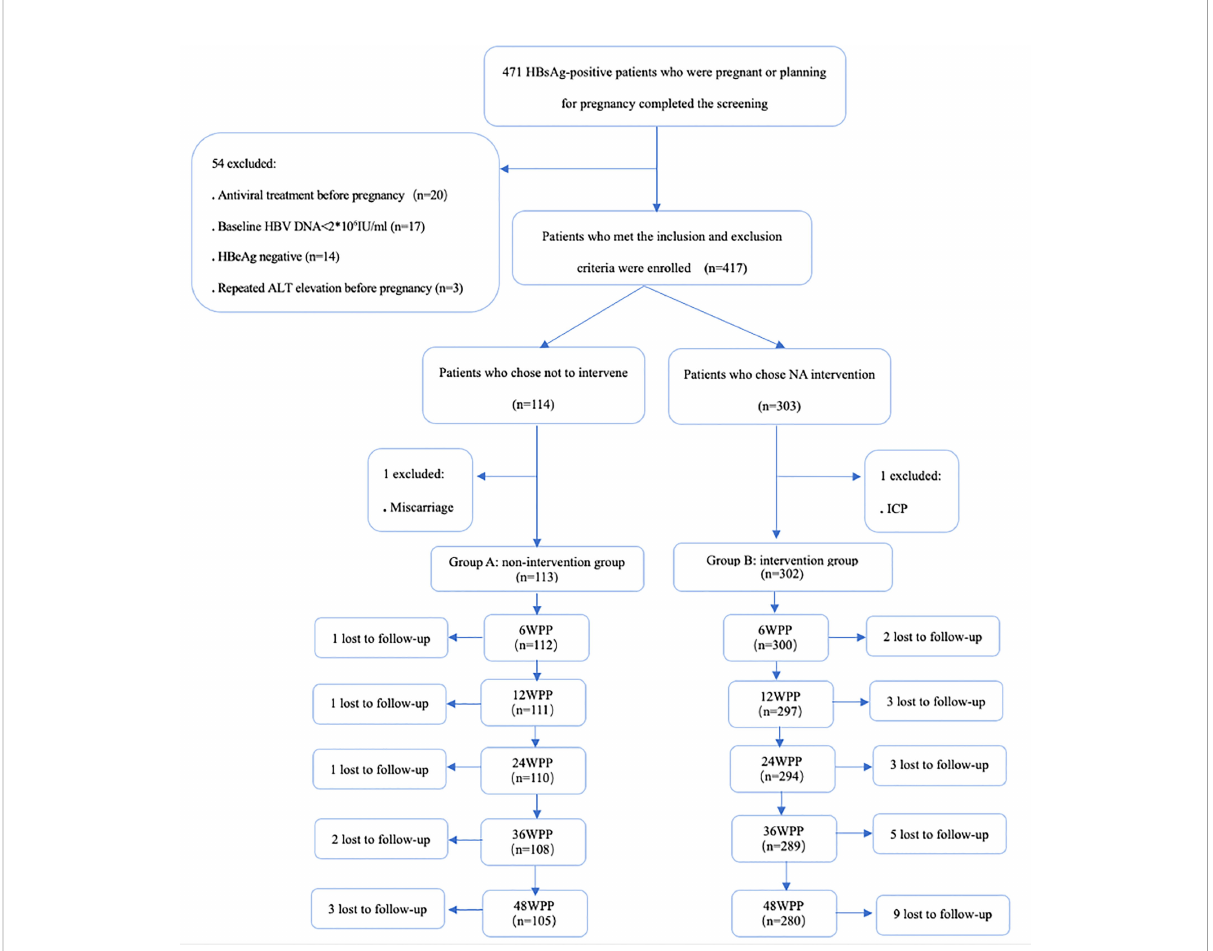
FIGURE 1 Flow chart of enrollment and follow-up of women who were chronic HBV carriers. HBsAg hepatitis B surface antigen, HBV hepatitis B virus, HBeAg hepatitis B e antigen, ALT alanine aminotransferase, NA nucleos(t)ide analogue, ICP intrahepaticcholestasis of pregnancy, WPP weeks